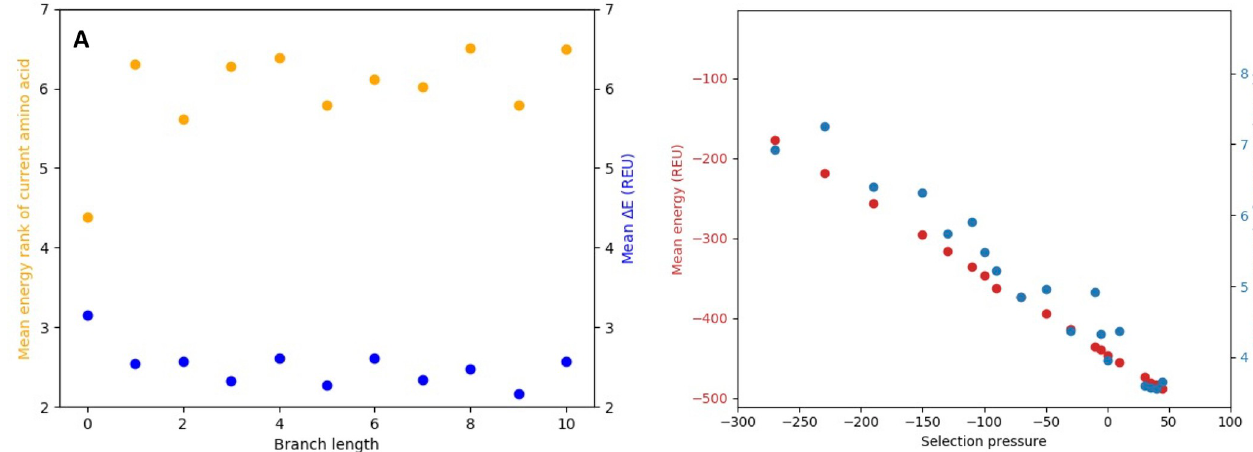
Fig 2. Equilibration of azurin. A) Mean change in energy (blue) relative to the lowest energy amino acid choice and mean energy rank (orange) as a function of branch length for a simulation with selection pressure set to -162. The standard deviation for the Δ E values is on the order of 2.5 REU, while the error for the mean of energy is around 0.2 REU. B) Dependence of mean energy of accepted sequences (red) and mean rank (blue) on the selection pressure (fitness function offset).